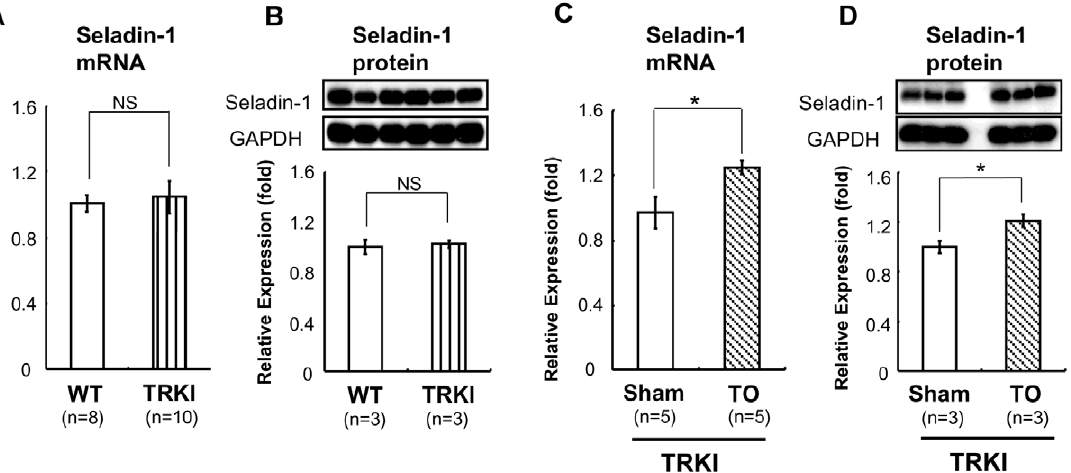
Figure 3. TO induced Seladin-1 mRNA and protein expression in the forebrain in TRKI mice. RT real-time PCR analysis for Seladin-1 was performed using mouse forebrain cDNA (A, C). Relative values (mean 6 S.E.) normalized by cyclophilin A mRNA levels compared with Sham are shown as relative expression (fold). Western blot analysis using mouse forebrain whole cell extract was performed (B, D). Representative Western blots for Seladin-1 are shown in the upper panel (B, D). The number of mice employed is indicated in the figures. Relative values (mean 6 S.E.) normalized by GAPDH protein levels compared with Sham are shown as relative expression (fold). An asterisk indicates that the difference between the denoted pairs is significant at a confidence level of p , 0.05(*). NS: not